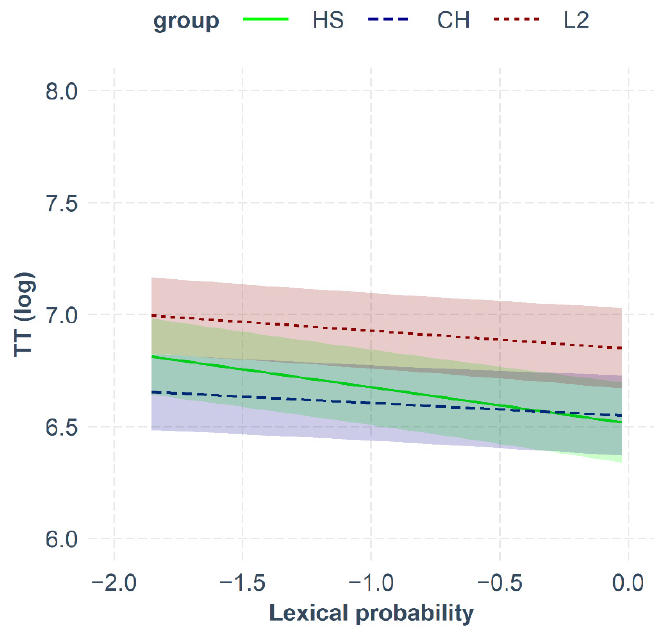
Figure 1. Interaction plot for the TT duration measure as a function of the lexical probability.